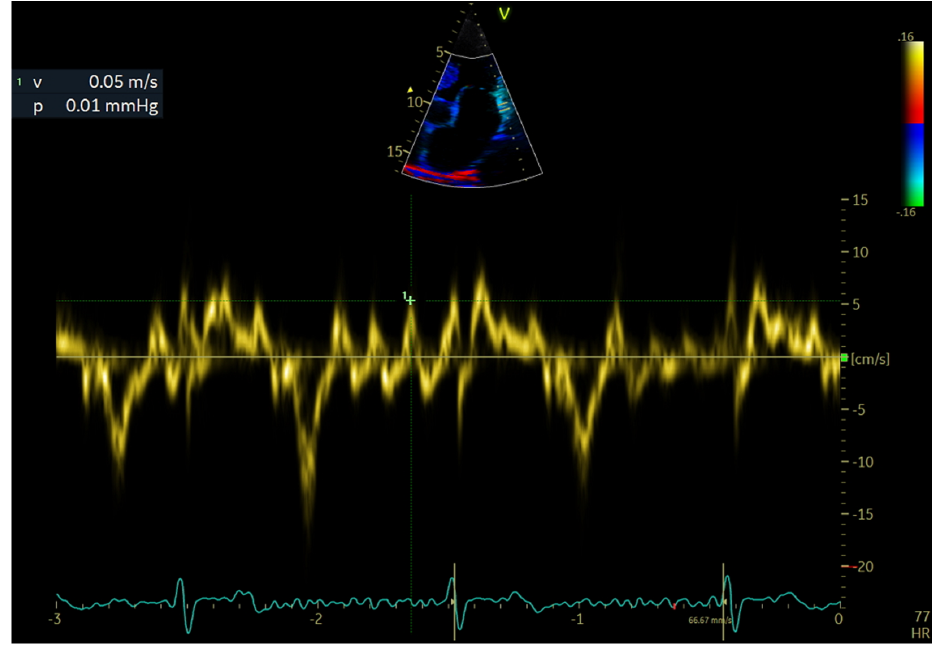
Figure 1. Left atrial wall motion velocity measurement. LAWMV of 5 cm/s towards the probe.